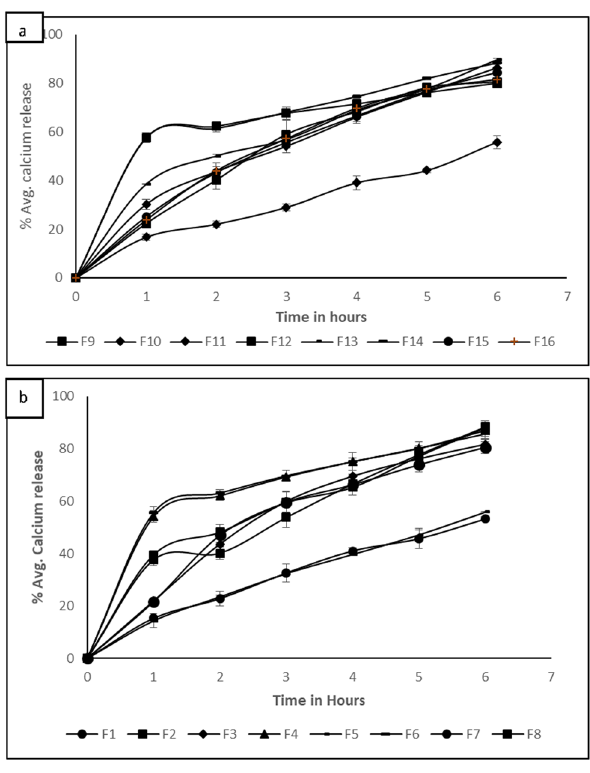
Figure 3: Comparative cumulative amount of calcium release from bilayer tablets of batches F1 – F8 ( a ) and F9 – F16 ( b )